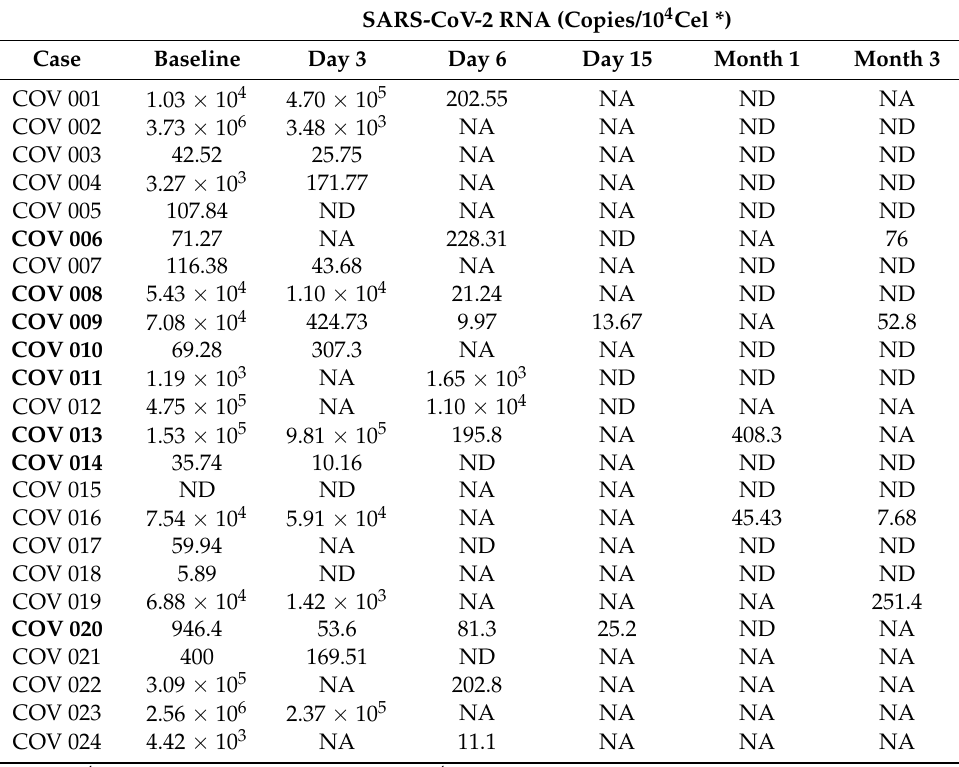
Table 2. SARS-CoV-2 RNA quantification from nasopharyngeal swab